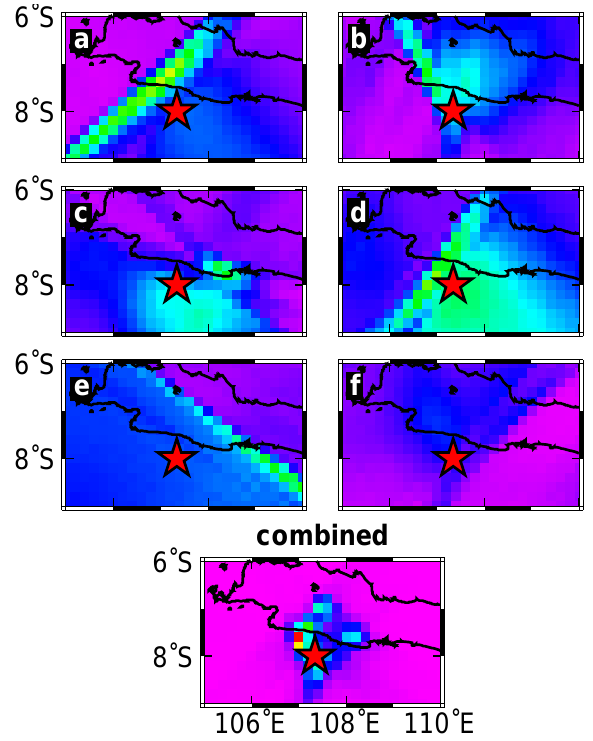
Fig. 2. Combination for semblance source maps by multiplication at the onset of the M 7 . 4 Java earthquake on 2 September 2009. As- suming source time, semblance source maps are computed at arrays in (a) Europe, (b) Africa, (c) East Asia, (d) eastern Mediterranean Sea (e) Alaska, and (f) Australia, New Zealand (compare Fig. 1). Colours indicate normalised